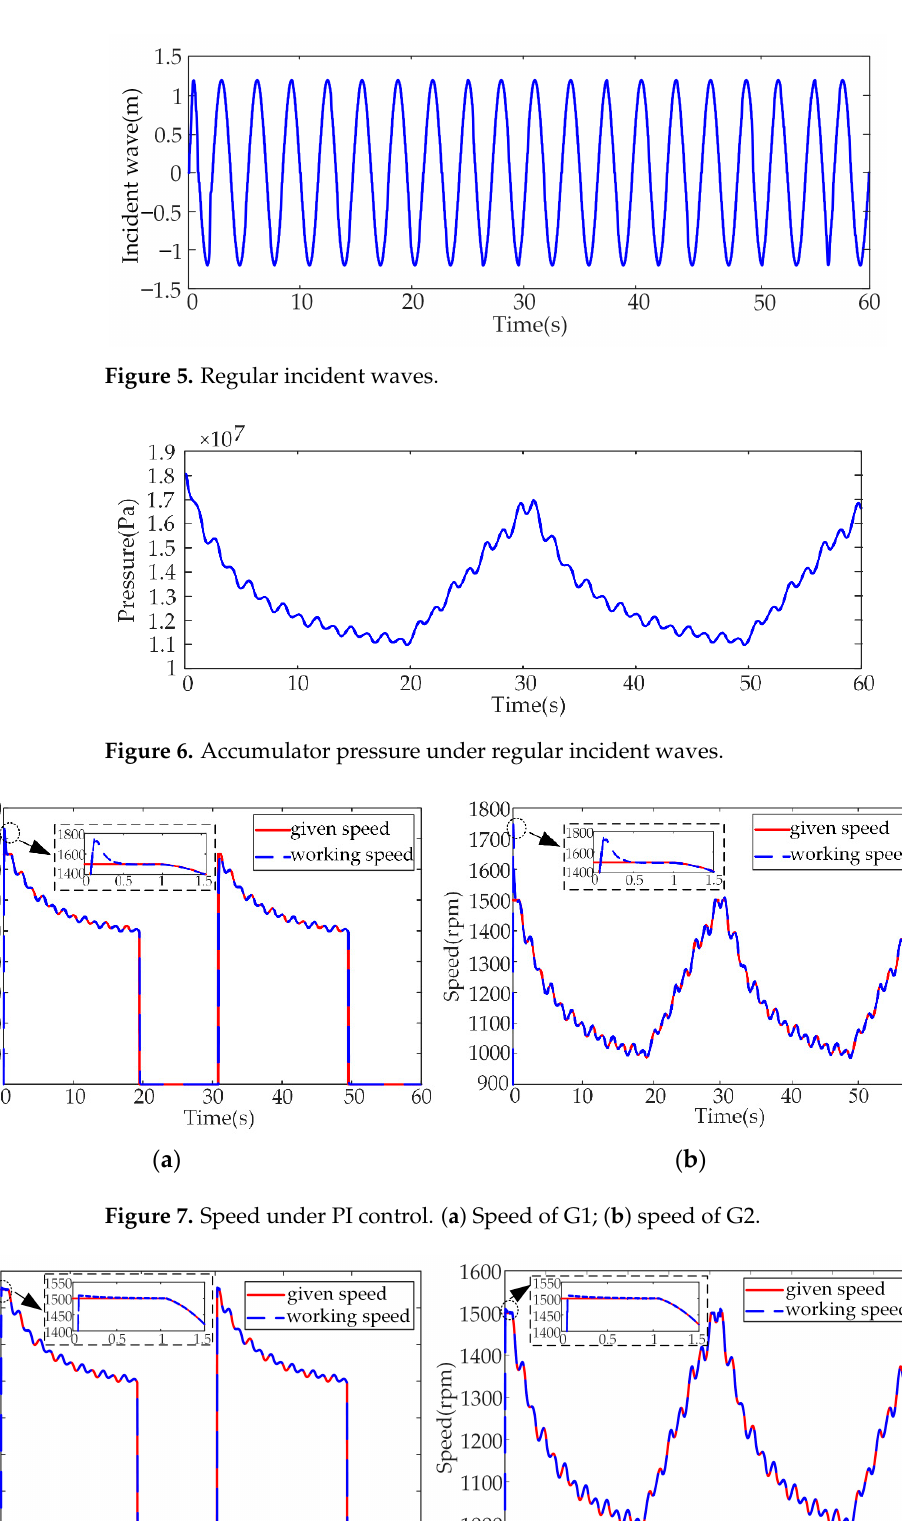
Figure 7. Speed under PI control. ( a ) Speed of G1; ( b ) speed of G2.